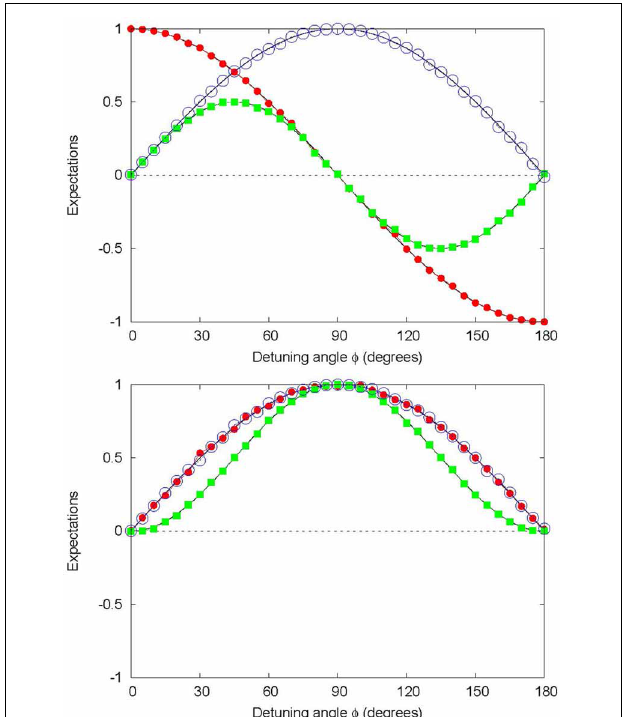
FIGURE 3 | Results for the expectations (cid:2) S 1 (cid:3) (red solid circles), (cid:2) S 2 (cid:3) (green solid squares), and (cid:2) S 1 S 2 (cid:3) (blue open circles) as obtained by the event-by-event simulation of the neutron experiment [14, 15], using the model Equation (18) for the spin analyzers. The solid lines represent the corresponding quantum theoretical prediction as obtained from Equation (9). Top: incoming particles have magnetization ( 1 , 0 , 0 ) . Bottom: incoming particles have magnetization ( 0 , 1 , 0 ) . For each pair of settings ( S 1 , S 2 ) of the spin analyzers (SA2,SA3) and each position of the pair of spin flippers (SF2,SF3) represented by a rotation of φ about the z -axis, referred to as detuning angle in Erhart et al. [14], Sulyok et al. [15], the simulation consists of sending N = 10000 messengers (“neutrons”) into stage 2.